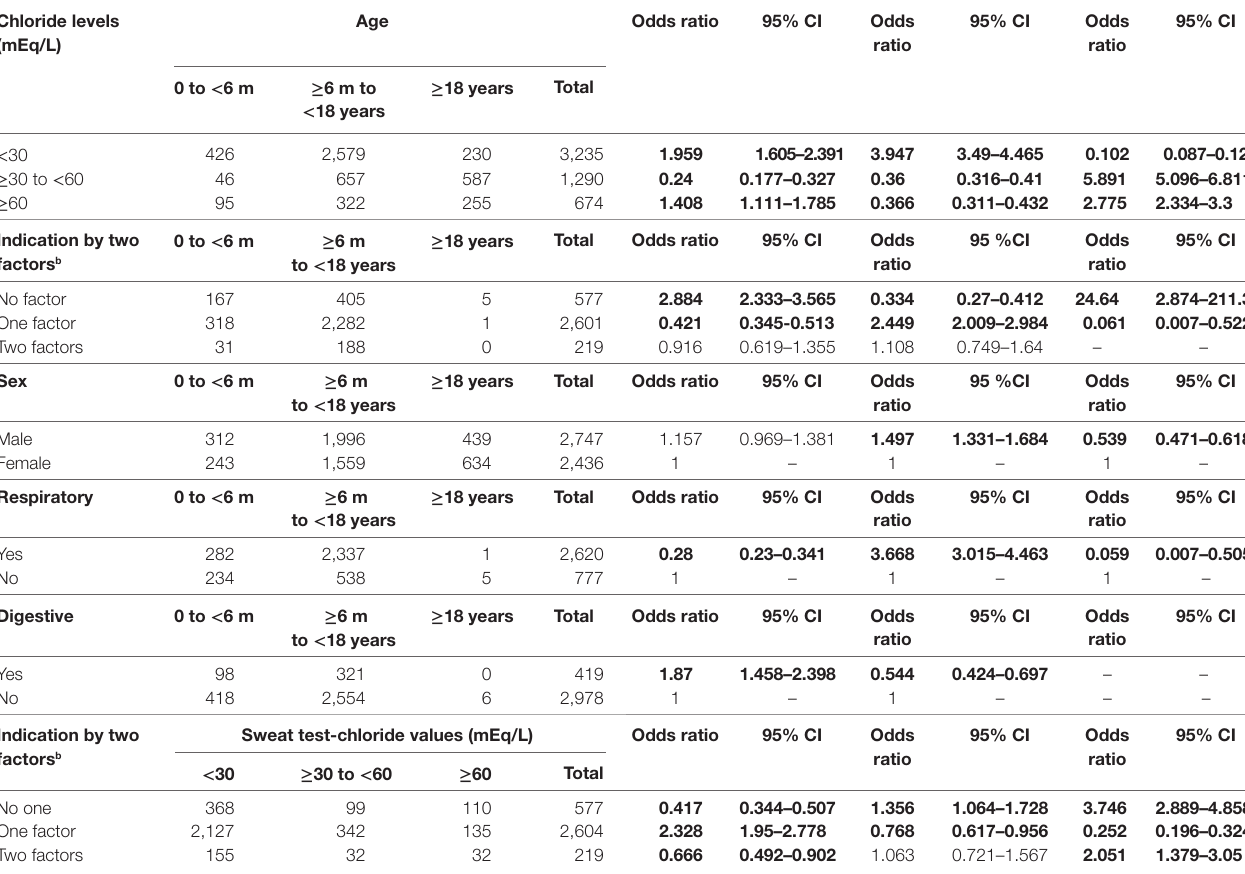
Table 2 | Association between sweat chloride levels, sex of the subjects, and reason for indication of sweat test with age and sweat test result. chloride levels